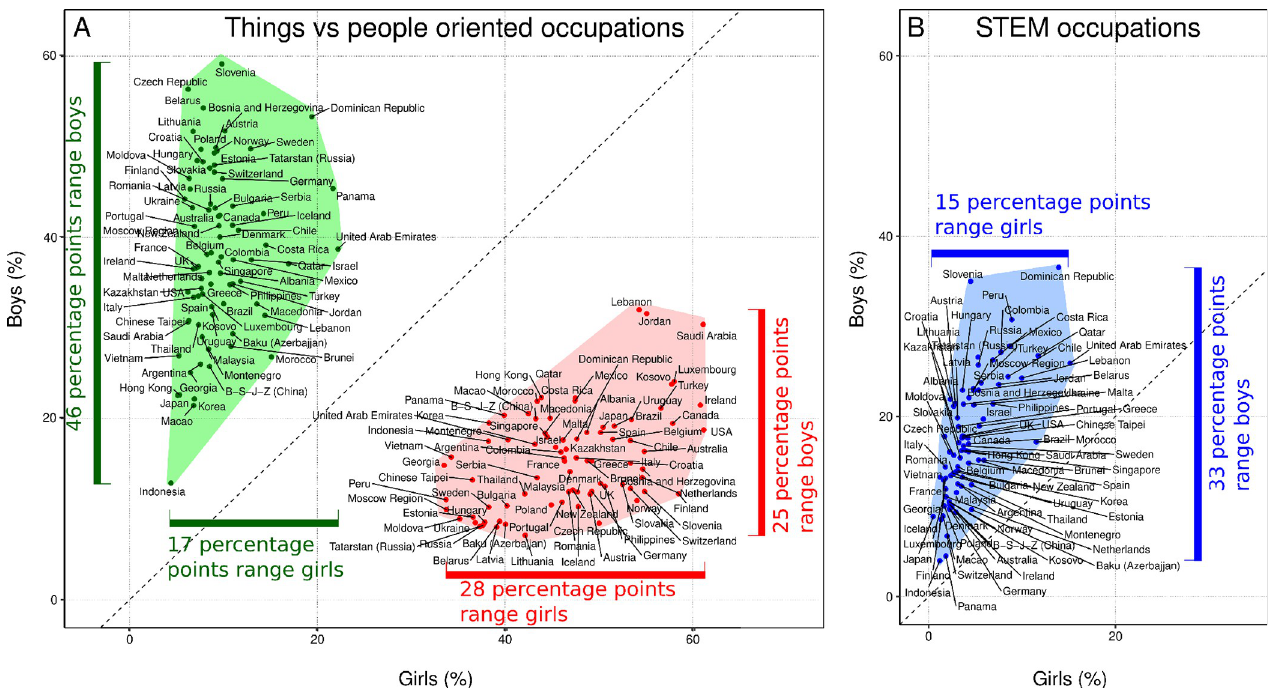
Fig 2. Percentage girls and boys aspiring to work in people-oriented occupations (panel A, red), things-oriented occupations (panel A, green) and STEM occupations (panel B, blue). Note that in all countries, more girls than boys aspire to a people-oriented occupation, hence all (red) points are below the line of equality (45˚); similarly, in all countries, more boys than girls aspire to a things-oriented or STEM occupation, hence all green and blue points are above the lines of equality. Note that the international variation in things-oriented and STEM occupations is much larger for boys than for girls.